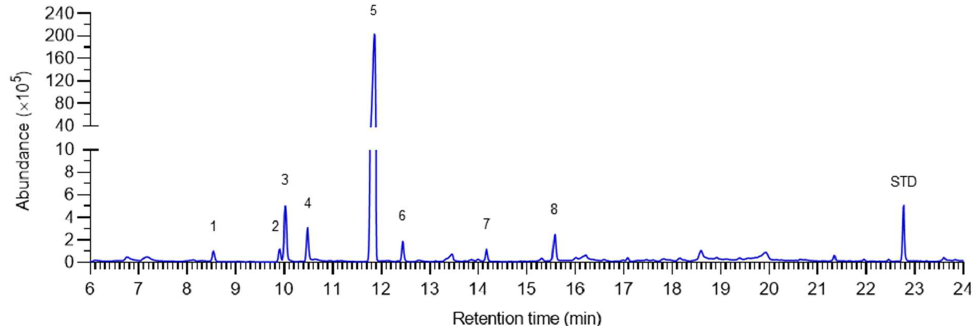
Figure 1. Chromatograph showing the chemical profile of pomelo extract. The numbers indicate the compounds described in Table 1, and STD indicates the internal standard ethyl decanoate.